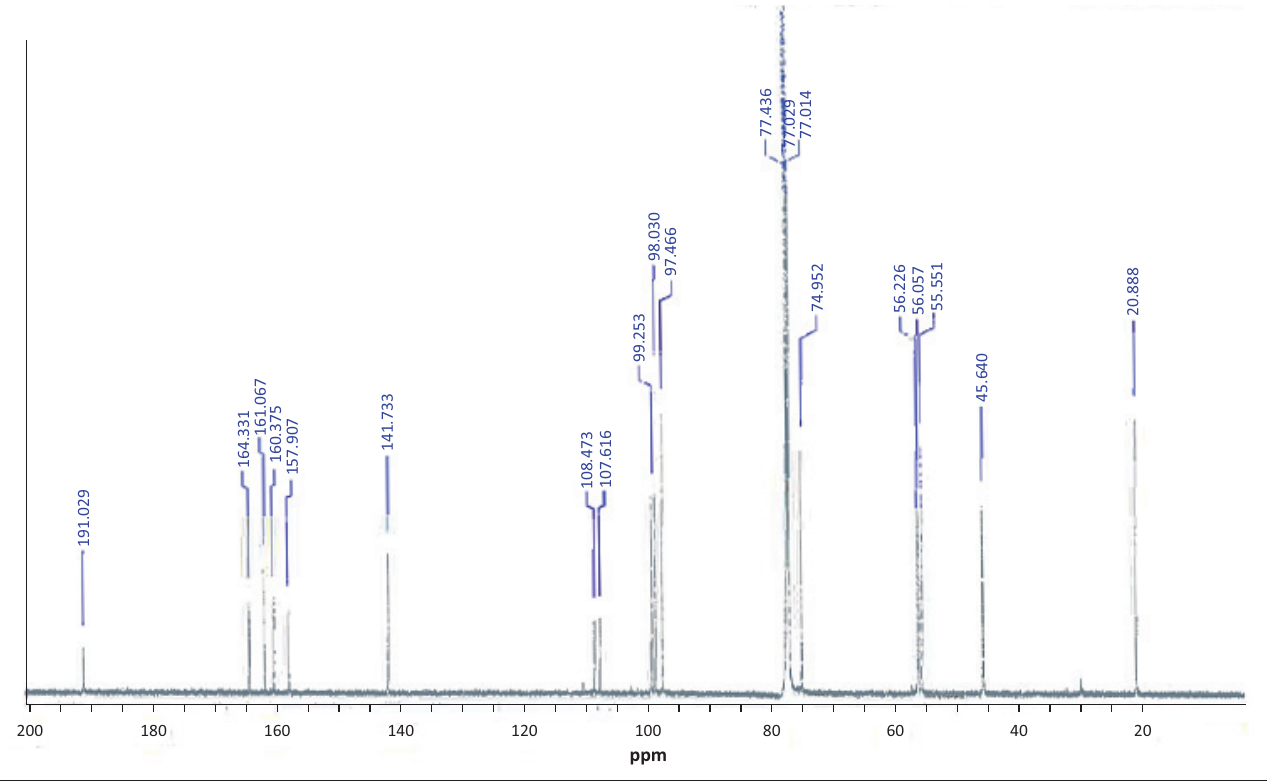
FIGURE 5: 13 C-NMR spectral data (600MHz, CDCl3) of sub-fractions of the dichloromethane fraction of G. senegalensis showing 17